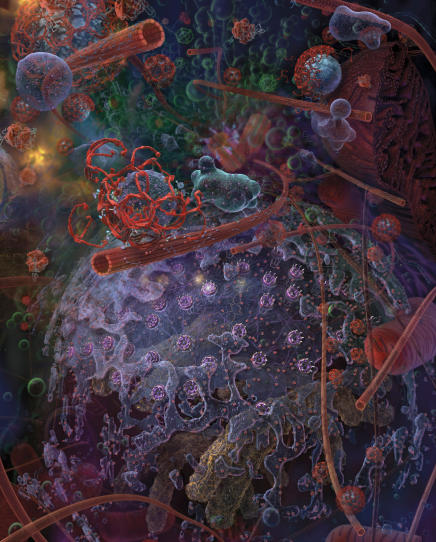
Cell SignalingThis is a detail cropped from a 36-inch-tall painting created by Graham Johnson for the textbook Cell Biology by Tom Pollard and Bill Earnshaw (W. B Saunders-Elsevier 2007). The painting depicts the process of cell signaling, starting from an initiating signal at a cell surface receptor (not shown here) and ending with mitosis. Details along the chain of events were used as chapter openers in the book, and the entire painting was presented as a poster.